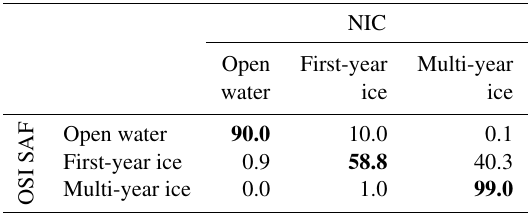
Table 13. Averaged percent agreement of NIC weekly ice chart and OSI SAF daily sea ice type product (OSI-403-c) for the same publication dates (12 different days) in the studied domain during January–March 2019. Bold indicates where the classification was done